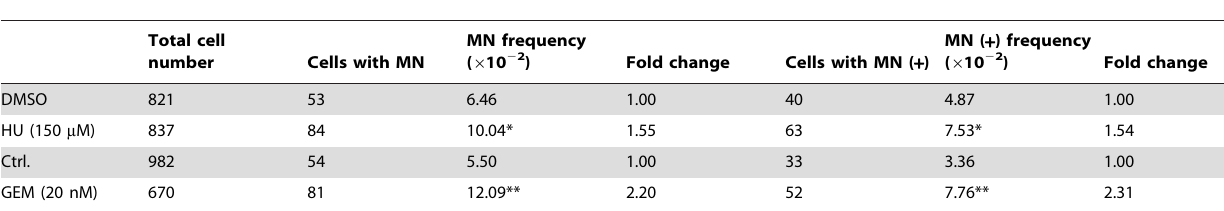
Table 3. Induction of MN and MN ( c - H2AX + ) by HU and GEM (48 hours after release).